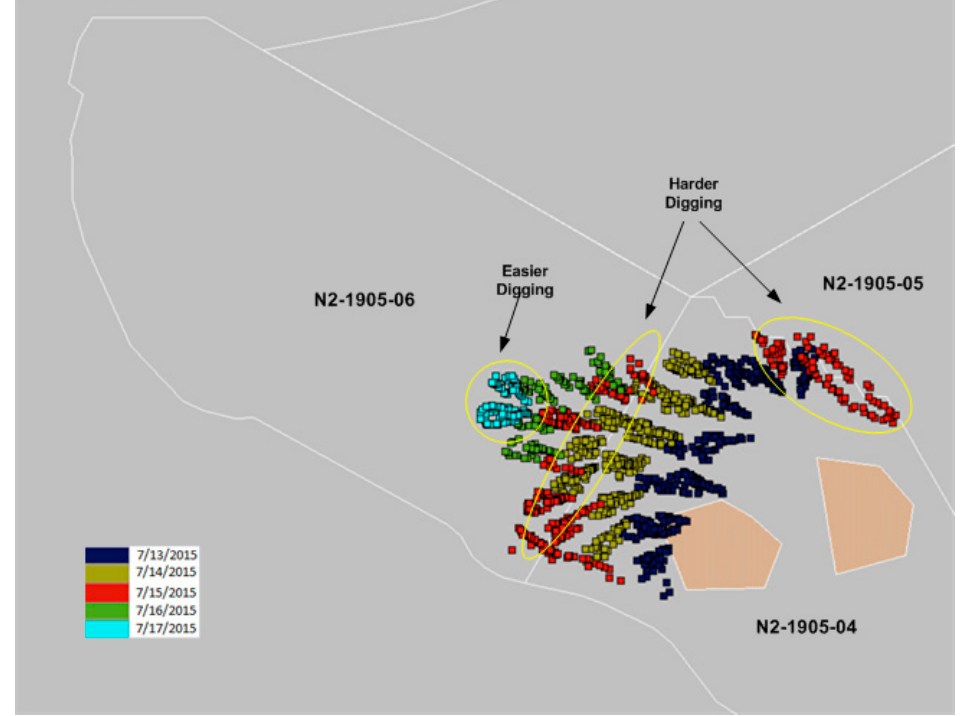
Figure 2. Shovel dig playback during the field trial (provided by mine).